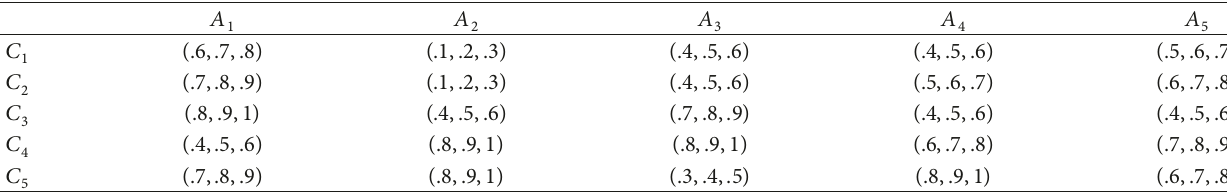
Table 2: Fuzzy decision matrix of expert